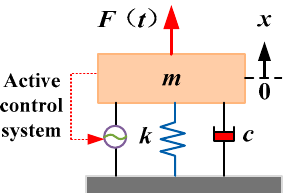
Figure 5. Typical schematic diagram of an integrated active–passive vibration isolation system.